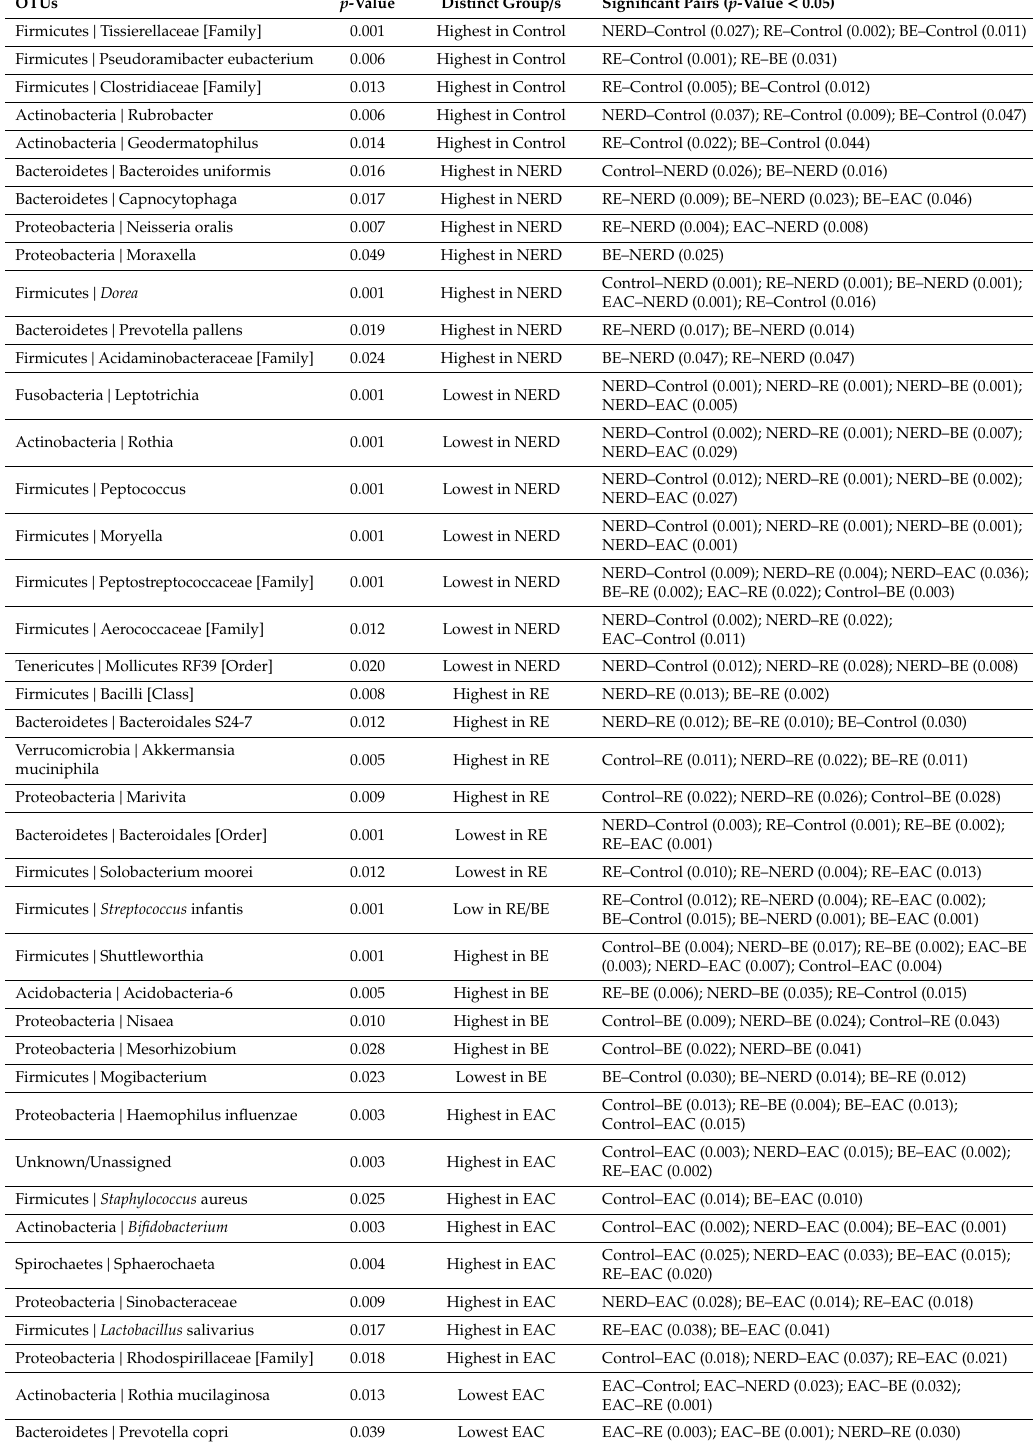
Table 2. Significant pairs within the 41 di ff erential operation taxonomic units (OTUs) between non-erosive reflux (NERD; n = 11), reflux esophagitis (RE; n = 20), Barrett’s esophagus (BE; n = 17), esophageal adenocarcinoma (EAC; n = 6), and